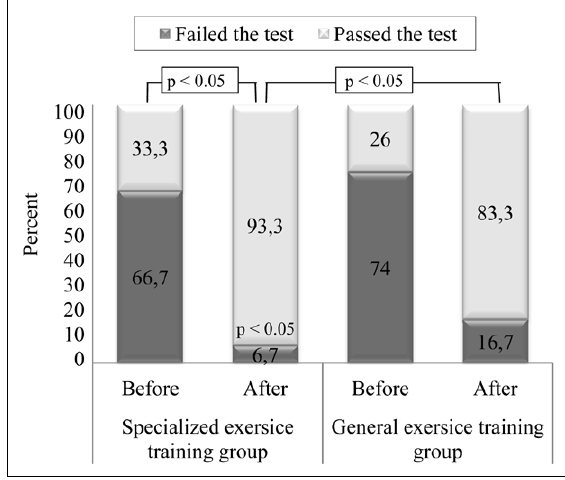
Figure 7. “Quadruped position”